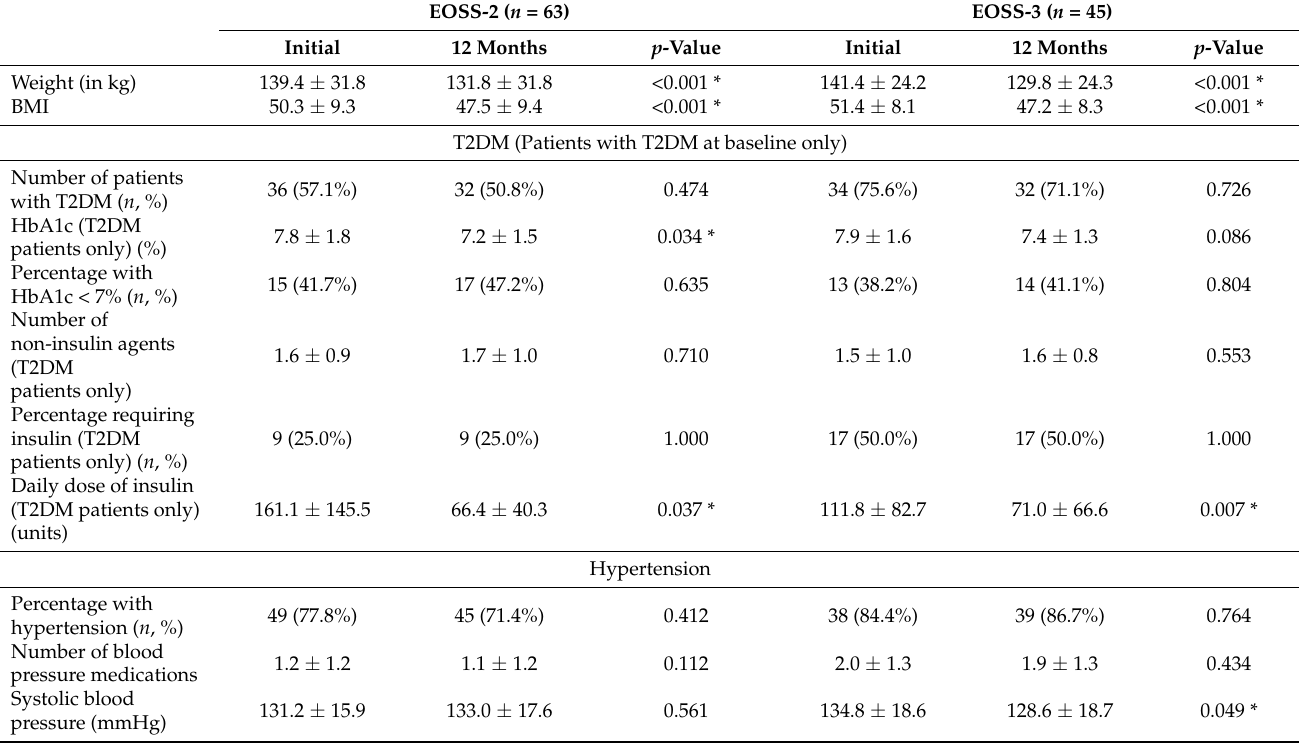
Table 3. Initial and 12-month outcomes by EOSS